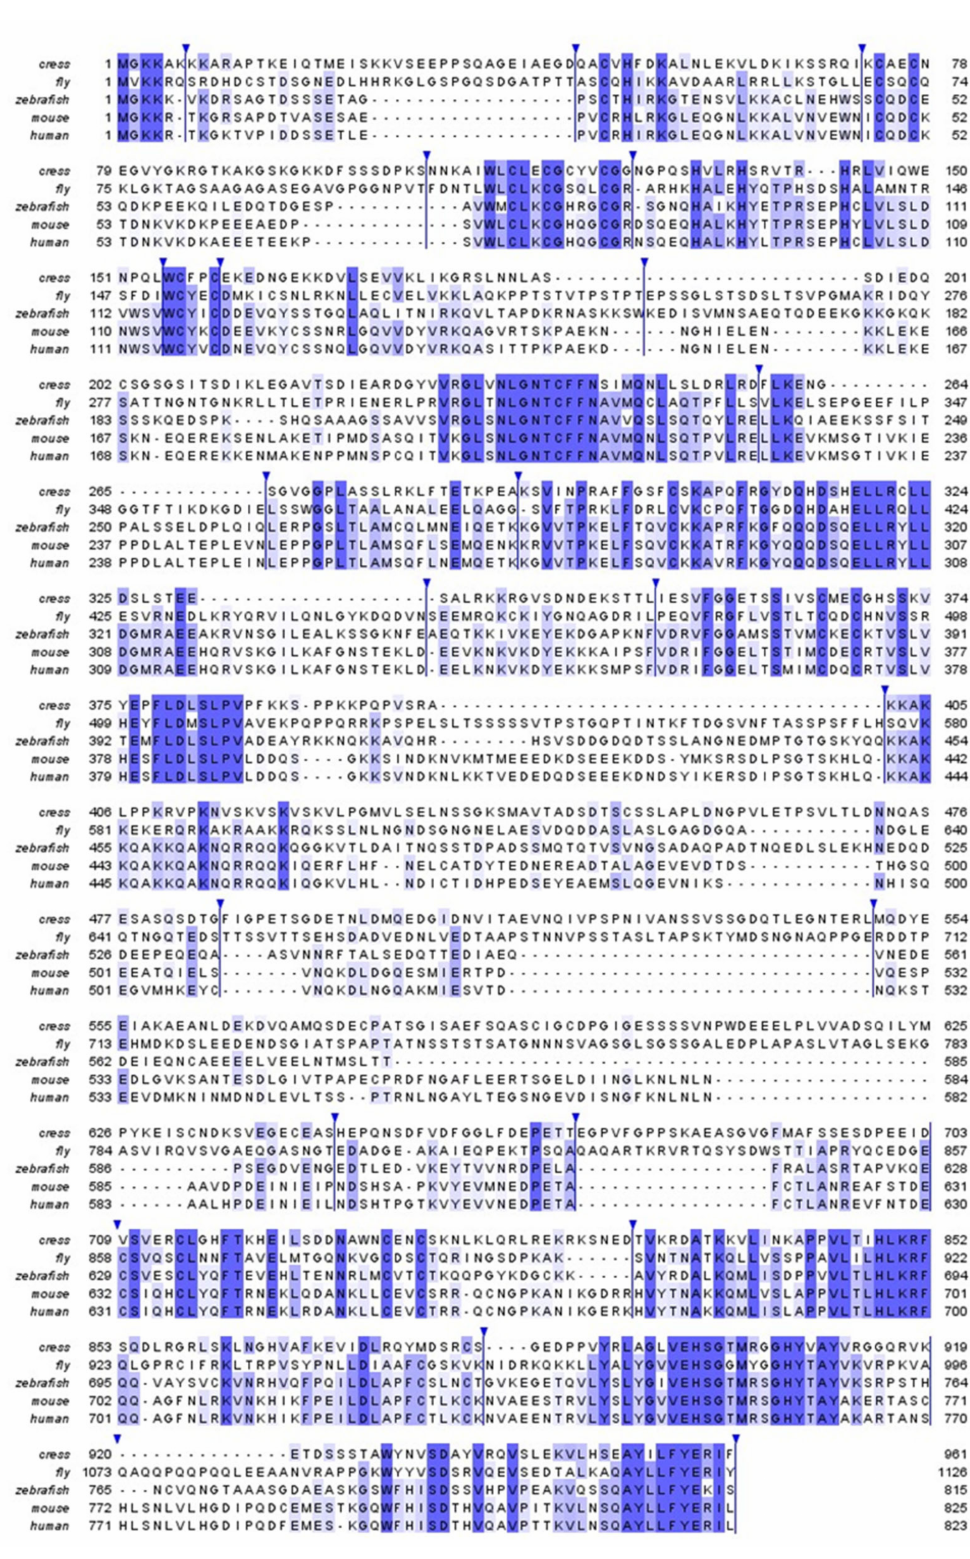
Figure 2. Sequence alignment of USP16 from five species. Sequences of human, mouse, zebrafish, fly, and thale cress USP16 homologs were aligned MAFFT algorithm. The sequences are colored according to percentage identity. Sequence fragments that exist only in one of the five homologs are removed from the alignment for clarity and indicated with a marker. The image was prepared using